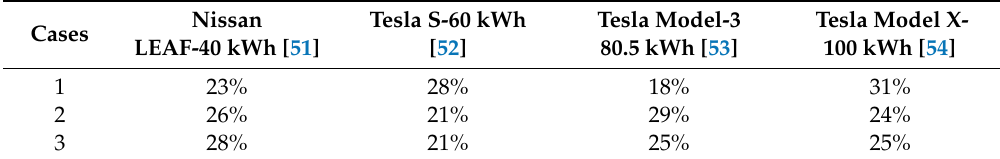
Table 7. Random distribution of di ff erent type of EVs.